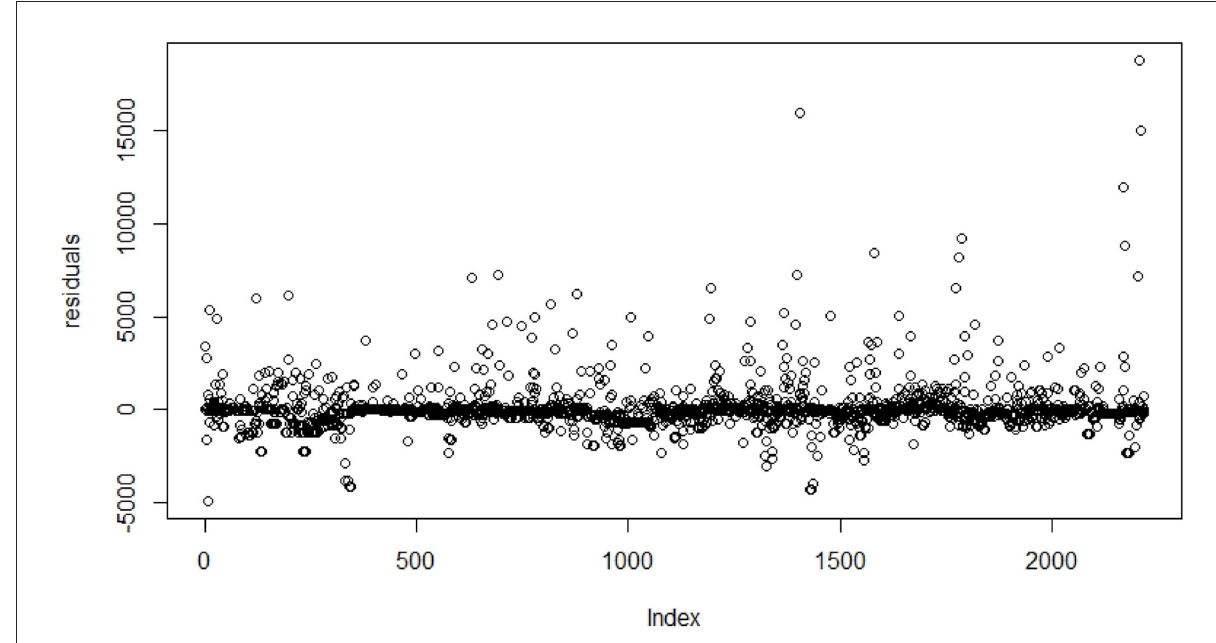
FIGURE3 Residual plot for predicted value on test data set under